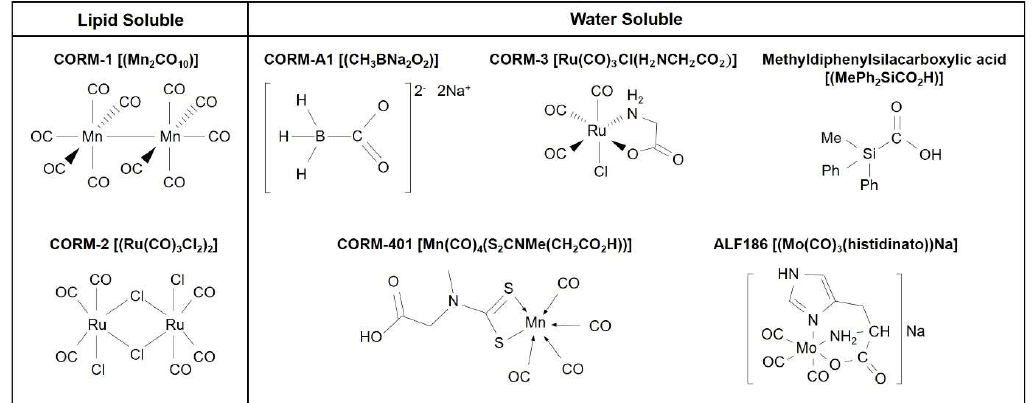
Figure 1. Structure and chemical components of CO-releasing molecules (CORMs).